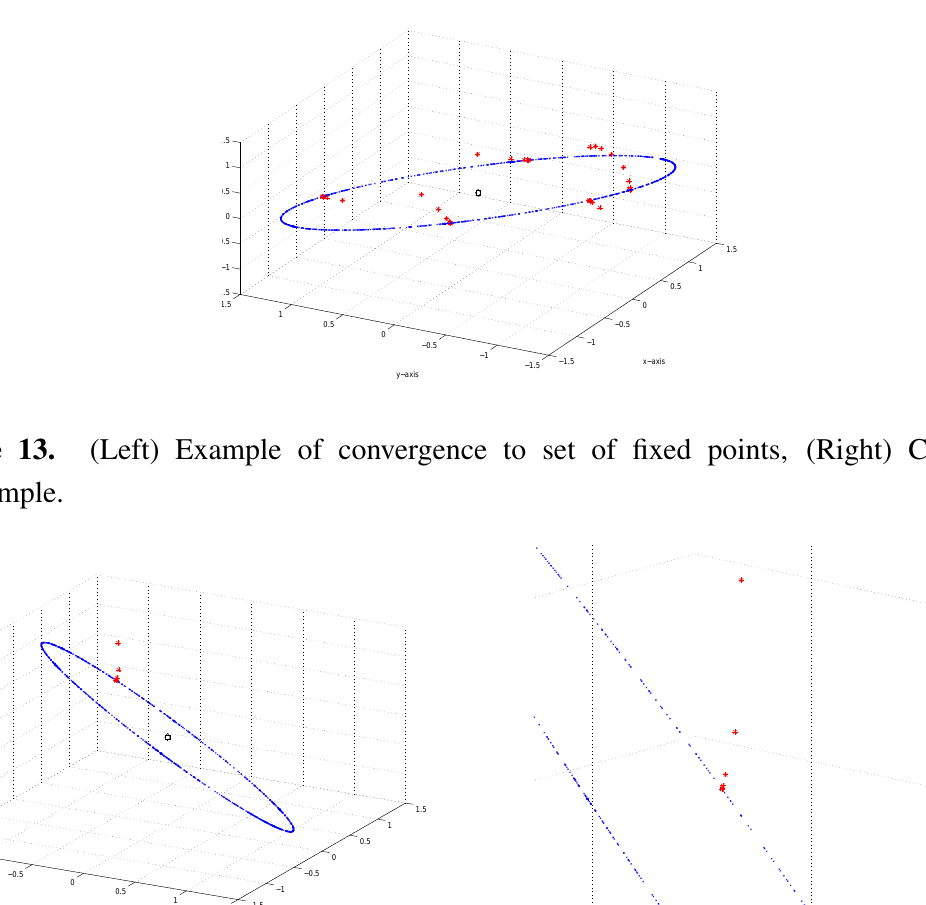
Figure 12. Illustration of convergence to fixed points from multiple starts.